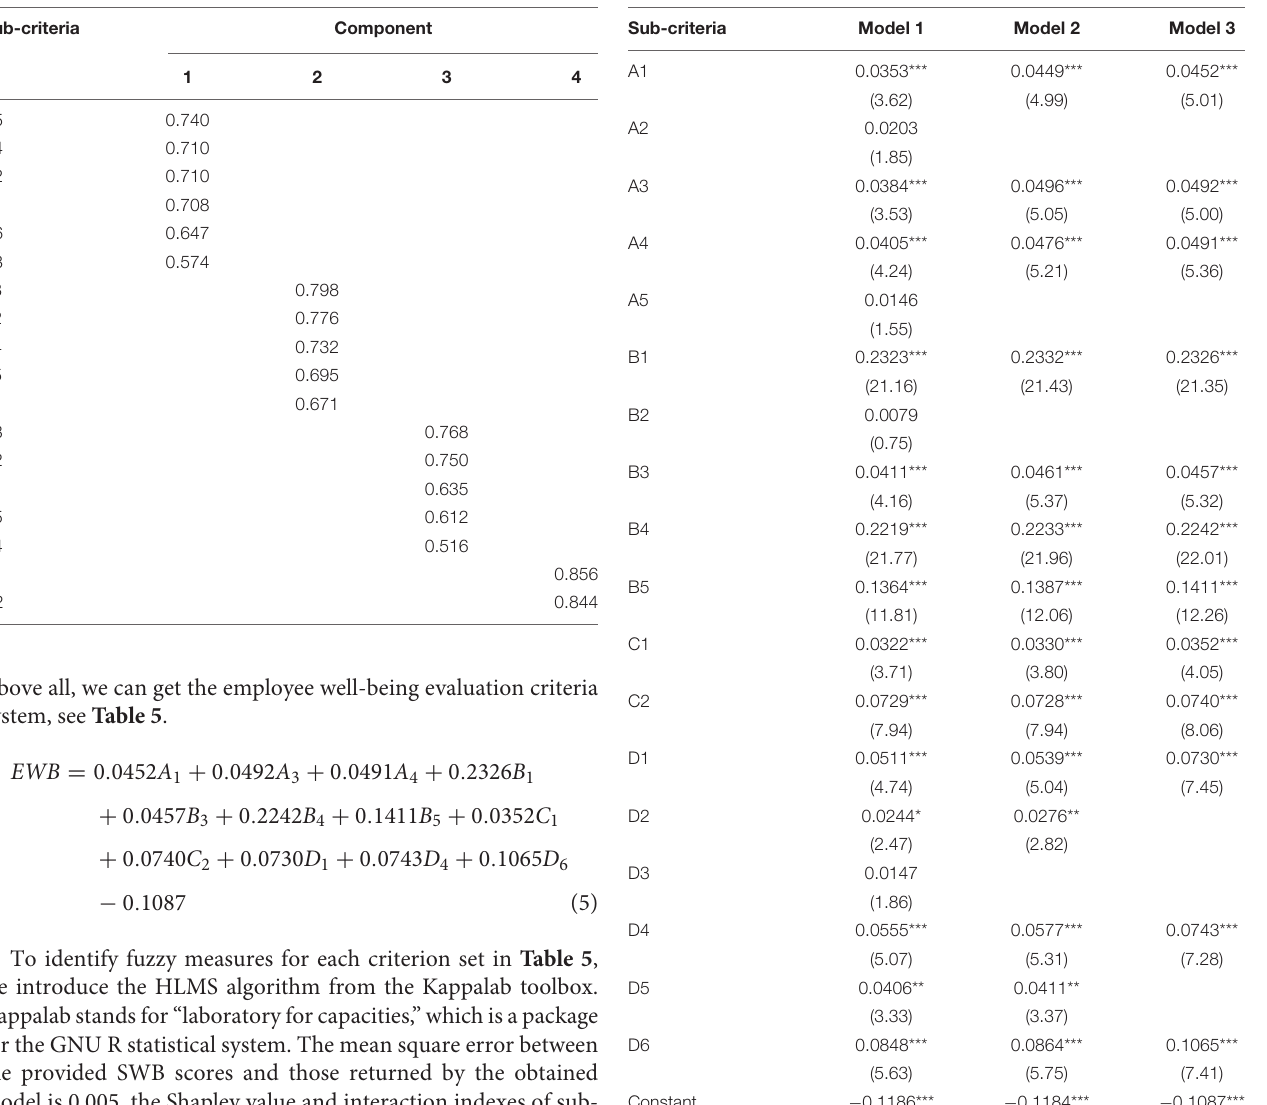
TABLE 4 | Multiple linear regression results for preliminary sub-criteria on